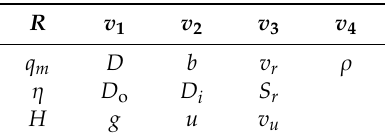
Table 1. The relationship between R and v i